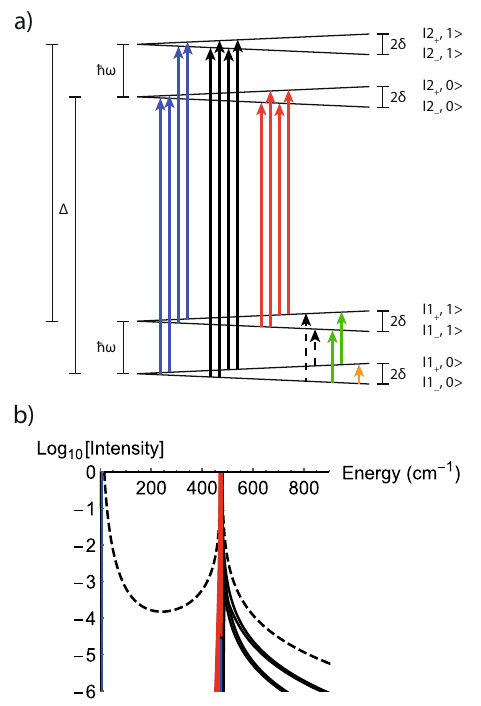
Fig. 4 Vibronic states and theoretical FIRMS intensity for toy model. a States of toy model; note that the vibrational energy _ ω is a variable, and all values are considered in (b). Purely electronic transitions are shown in blue, purely vibrational transitions in green, cold vibronic inter-KD transitions in black, vibrationally hot vibronic transitions in red, and cold vibronic intra-KD transitions in dashed black; EPR transitions (not studied in this work) in orange. b Absorption intensity for cold intra-KD vibronic transitions (black dashed lines), cold inter-KD vibronic transitions (solid black lines), hot inter-KD vibronic transitions (red solid lines), and purely electronic (solid blue lines, obscured by the red ones) transitions, under irradiation from an IR source with uniform intensity and uniform vibronic coupling. Purely vibrational transitions are not shown. Constructed with model parameters F = G = 1cm − 1 , A v = 10 2 , A = 1, Δ = 474cm − 1 and δ = 2cm − 1 ( fi eld ca. e